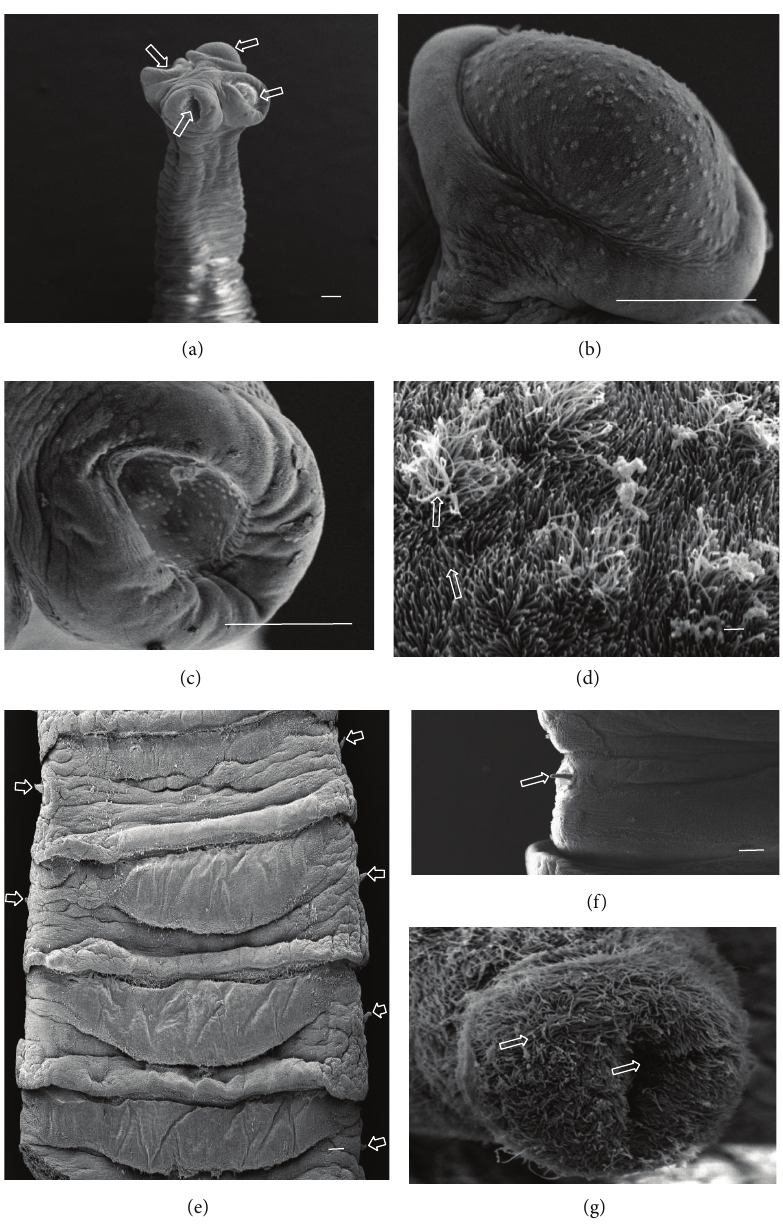
Figure 4: (a)–(g) Scanning electron micrographs of Moniezia expansa . (a) General anterior view of scolex, arrows show suckers. (b) Sucker evaginated. (c) Sucker invaginated. (d) Acicular and capilliform filitriches covering suckers (scale bar, 1 𝜇 m). (e) Portion of strobila showing craspedote proglottids and bilateral genital pores. (f) Portion of proglottid, arrow shows cirrus. (g) Cirrus fully covered by microtriches and showing cavity in center (scale bar, 1 𝜇 m). Scale bar = 100 𝜇 m, unless stated